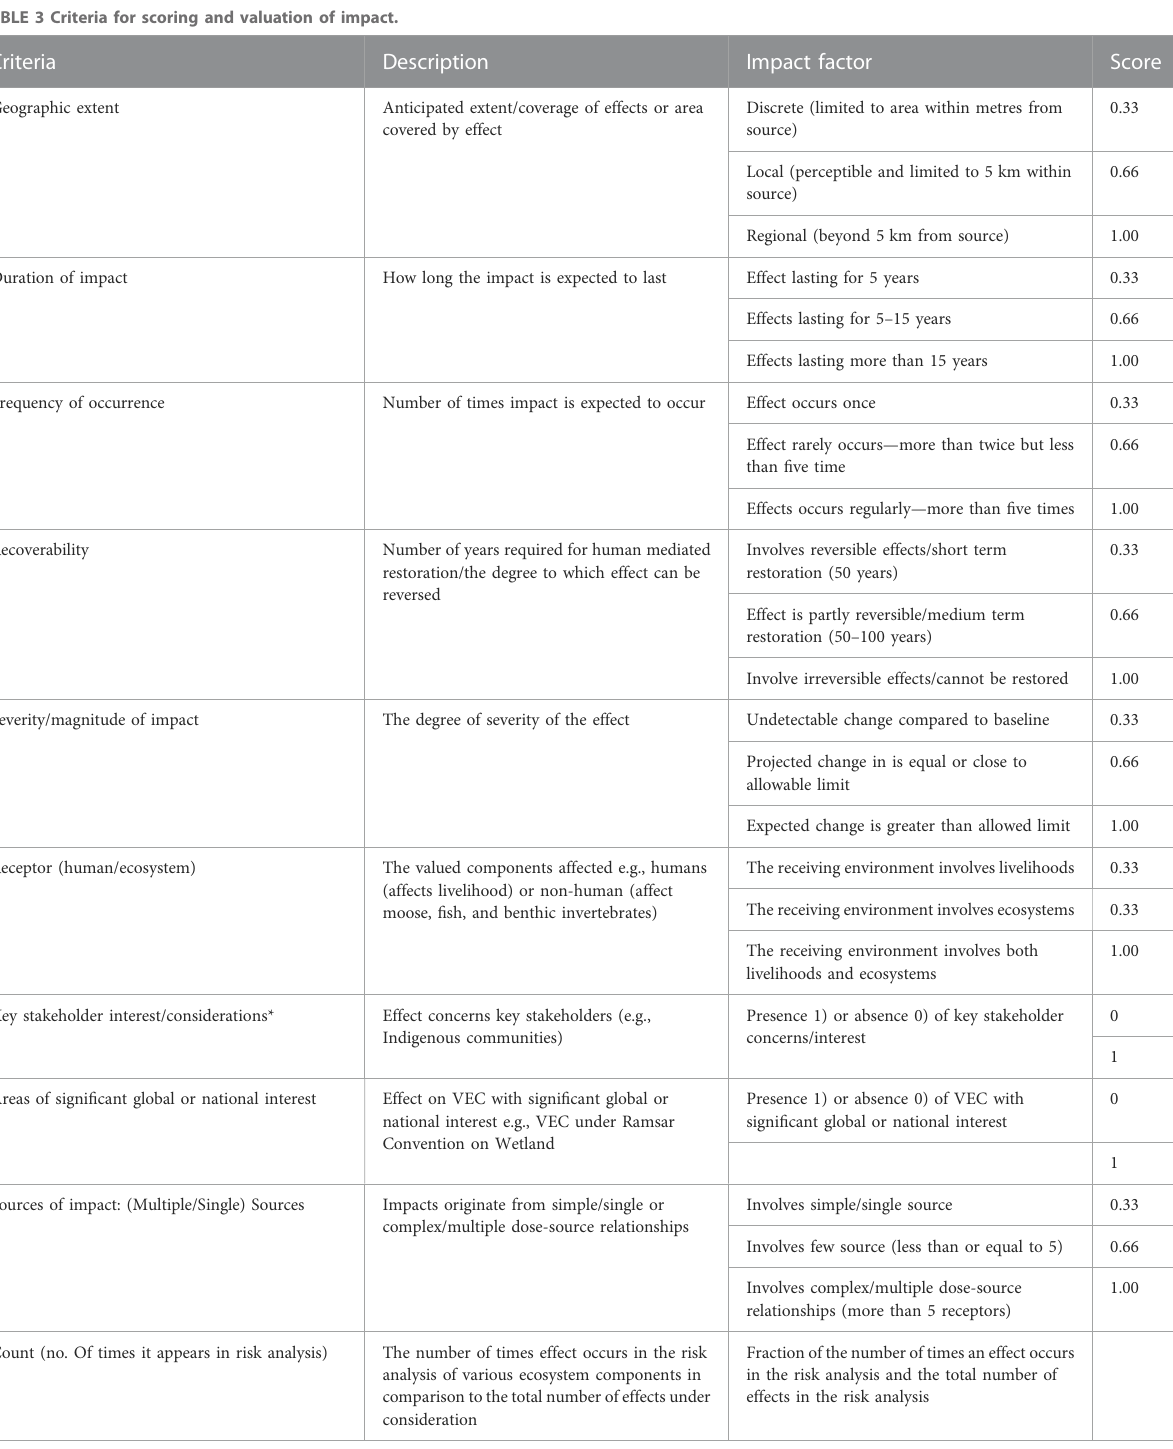
TABLE 3 Criteria for scoring and valuation of